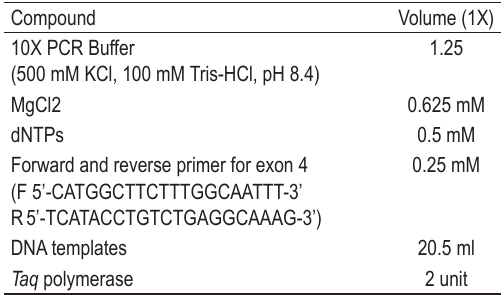
TABLE 1. PCR conditions for detection of mutation in exon 4 Compound